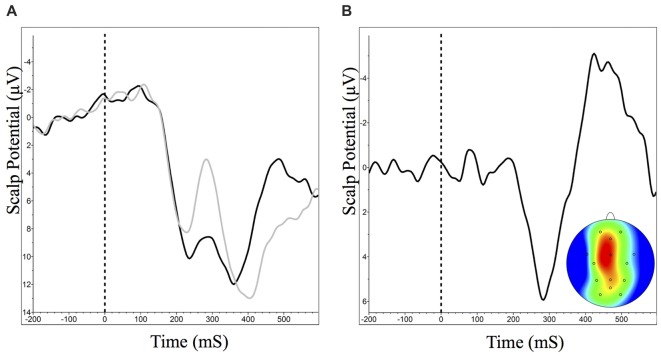
Grand averaged reward positivity ERP waveforms at FCz and scalp distribution for accuracy feedback in Module 1. Reward positivity is maximal between 264 ms and 304 ms following feedback presentation. Negative is plotted up. (A) ERP waveform at FCz in response to correct (dark) and incorrect (light) feedback. (B) ERP difference waveform and peak scalp distribution for correct minus incorrect accuracy feedback.